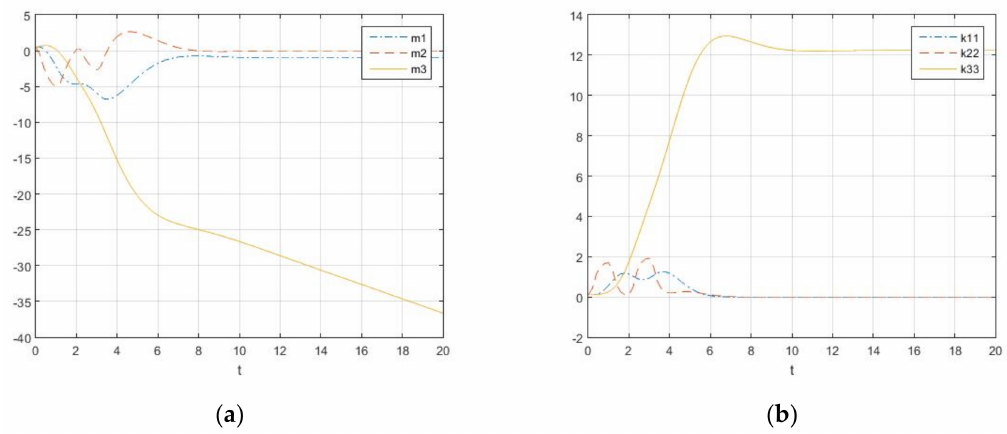
Figure 6. ( a ) Graphs m 1 , m 2 , m 3 at α = 180 ◦ , N = 2; ( b ) Graphs k 11 , k 22 , k 33 at α = 180 ◦ , N = 2.